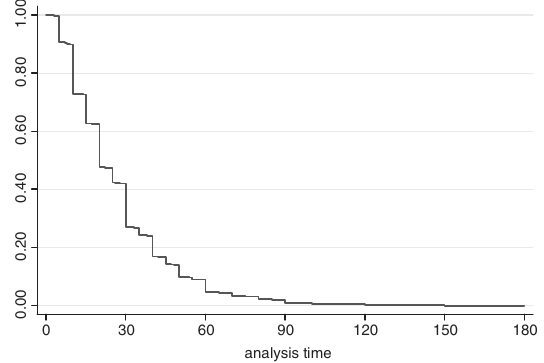
Fig. 2. The Kaplan Meier survival curve of home-to-work